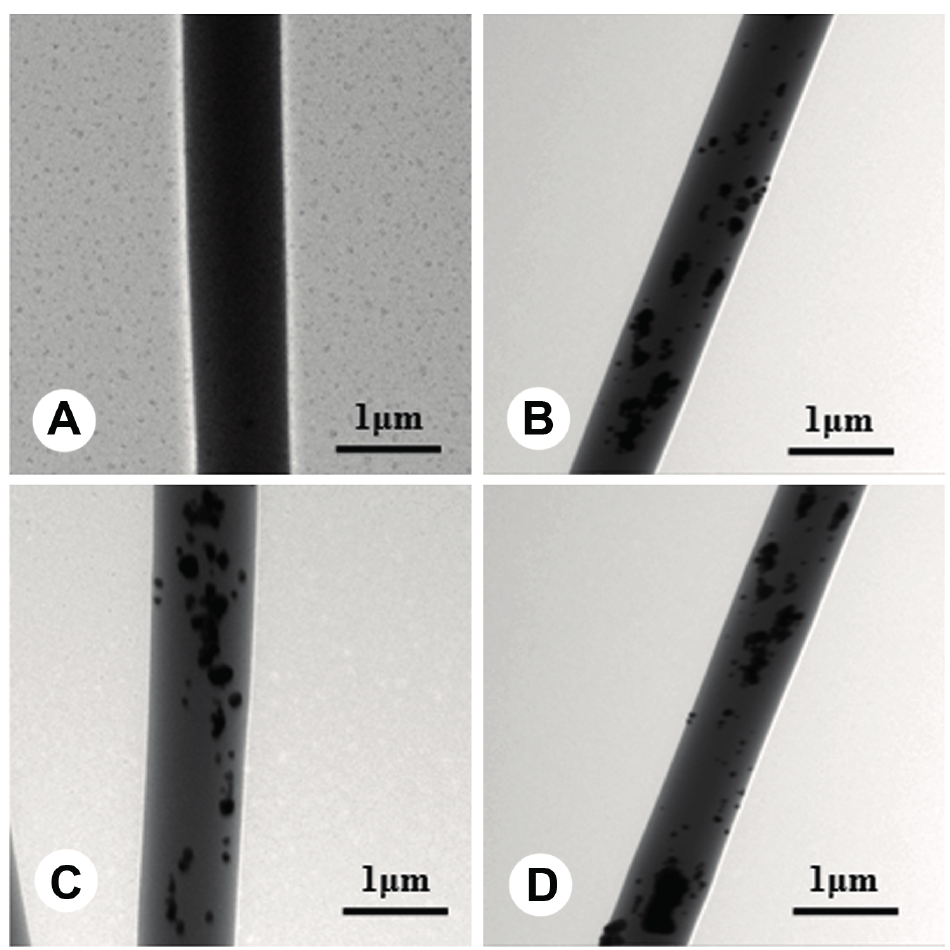
Figure 2. Transmission electron microscope (TEM) images of electrospun fibers of PLLA ( A